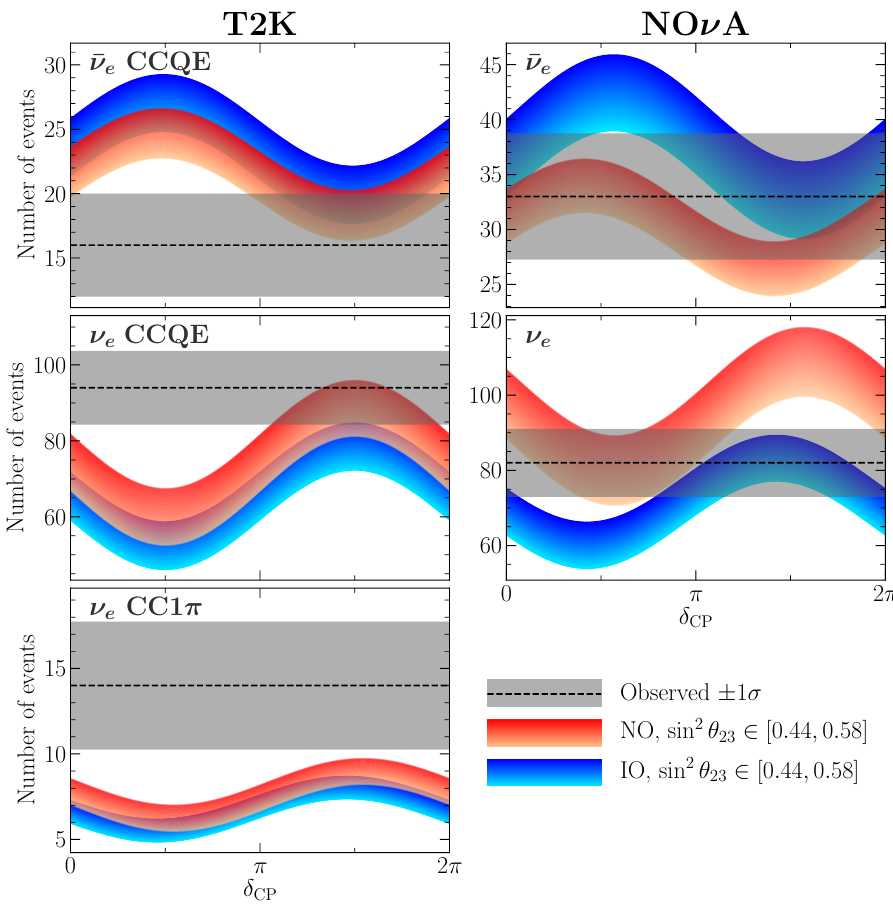
Figure 1 . Predicted number of events as a function of (cid:14) CP for the T2K (left) and NOvA (right) appearance data sets. sin 2 (cid:18) 23 varies between 0.44 and 0.58, where the lower-light (upper-dark) bound of the colored bands corresponds to 0.44 (0.58). Red (blue) bands correspond to NO (IO). For the other oscillation parameters we have adopted sin 2 (cid:18) 13 = 0 : 0224, j (cid:1) m 2 j = 2 : 5 (cid:2) 10 (cid:0) 3 eV 2 , 3 ‘ sin 2 (cid:18) 12 = 0 : 310, (cid:1) m 2 = 7 : 39 (cid:2) 10 (cid:0) 5 eV 2 . The horizontal dashed lines show the observed number 21 of events, with the (cid:6) 1 (cid:27) statistical error indicated by the gray shaded